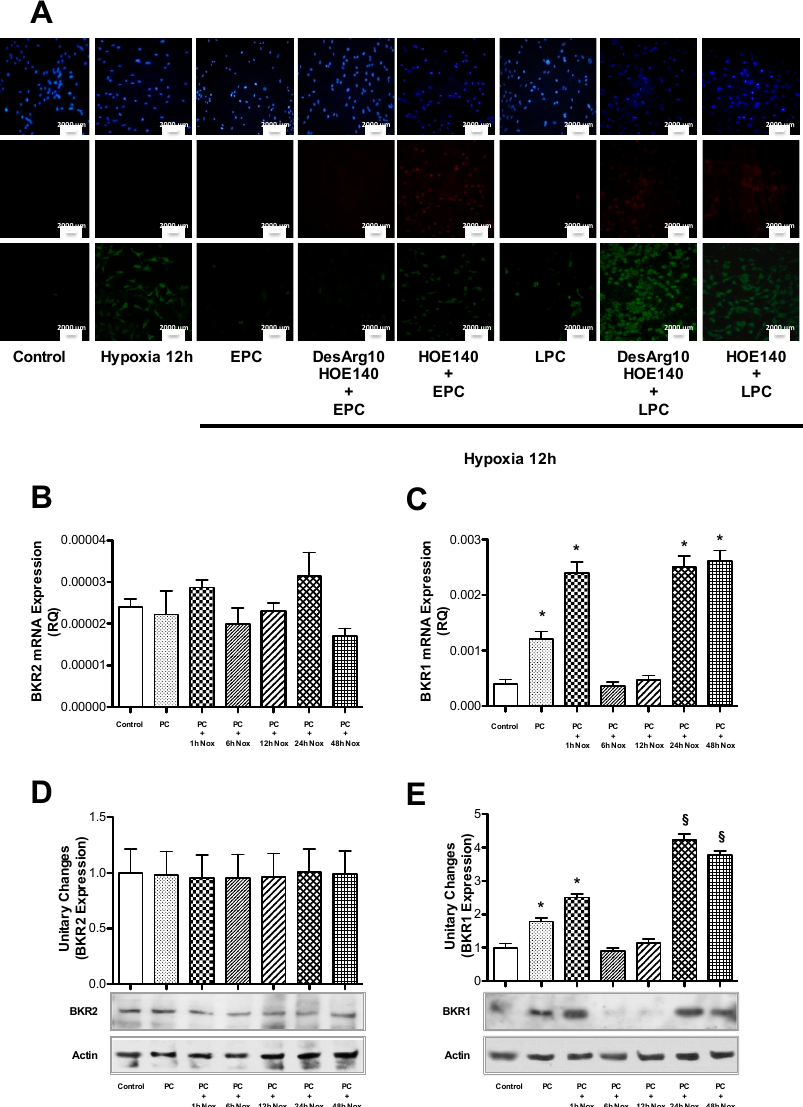
Figure 3. ( A ) Cells were subjected to prolonged hypoxia (12 h) after early and late preconditioning (EPC and LPC), in the absence and presence of selective bradykinin receptor 1 (BKR1) and 2 (BKR2) inhibitors (desArg10-HOE-140 and HOE-140, respectively). Cells were stained with Annexin-V (green), Propidium Iodide (PI, red) and DAPI (blue). The rates of apoptosis and necrosis were calculated by dividing the number of Annexin-V-positive / PI-negative cells and Annexin-V-positive / PI-positive